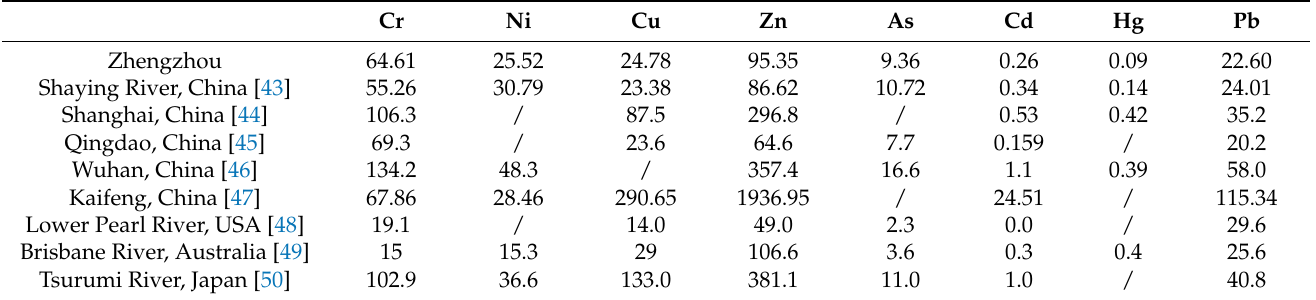
Table 5. Mean concentration of PTEs (mg/kg) in urban river surface sediments in various sites of cities and